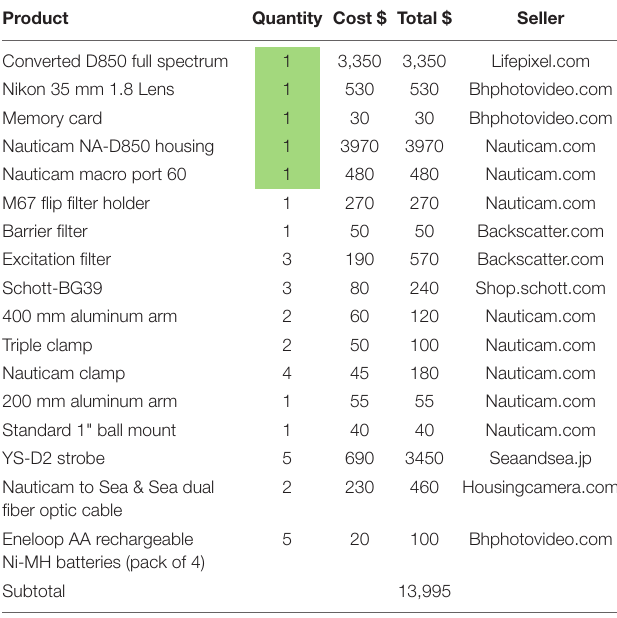
TABLE 1 | Full list of the equipment needed for the